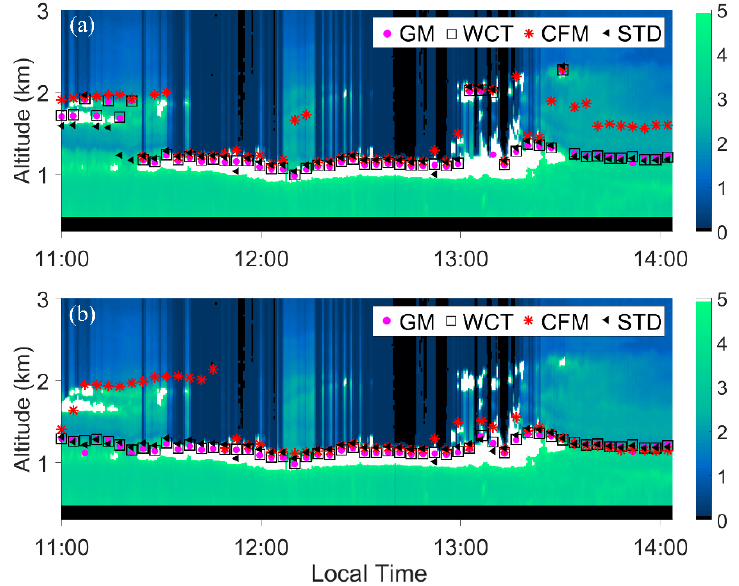
Figure 11. Same as Figure 9, except for 25 August 2017, 11:00–14:00 LT. Clouds are above and within the PBL presented as a white region during this period.